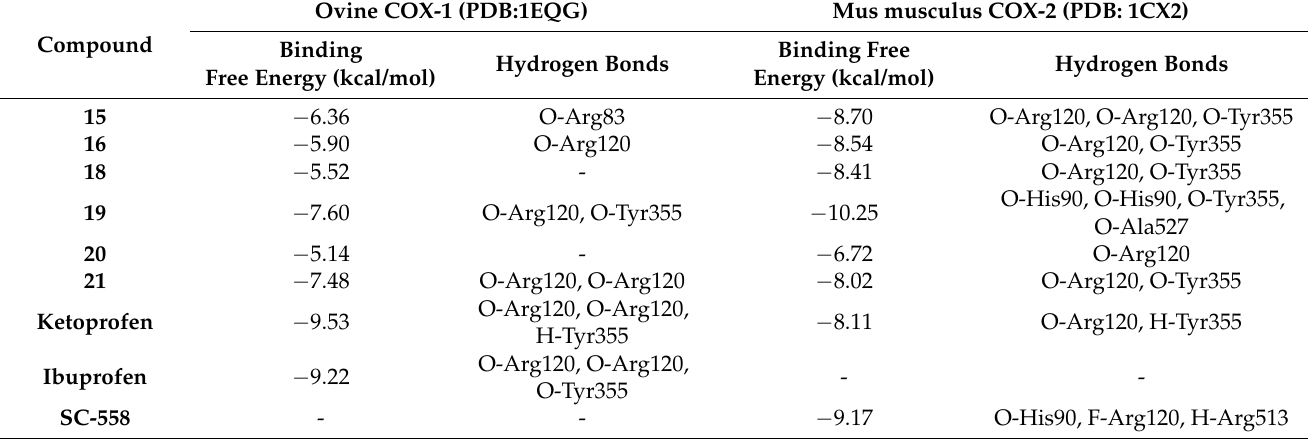
Table 5. Docking-assisted predicted values.